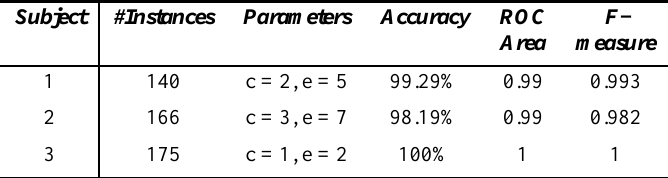
Table 3: Classification performance on Single String